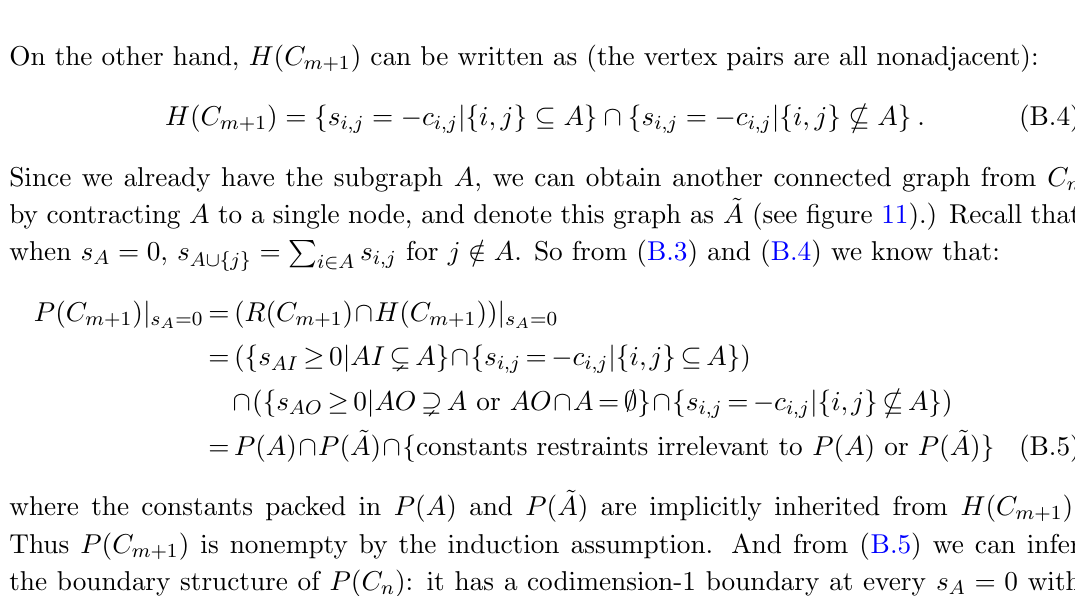
Figure 11. Example for A and ~ A from C n